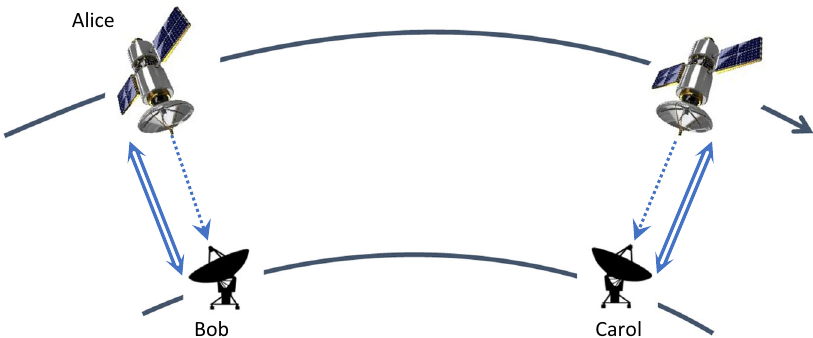
Fig. 1 Long-range quantum key exchange with satellite as trusted node. The dotted arrows represent quantum channels between the satellite (Alice) and each of the users (Bob and Carol). The white arrows represent classical public discussion channels, used to process the keys. By using both quantum channels and discussion channels, Bob and Carol can build a secret shared key. However, this secret key is also known to Alice, who therefore must be trusted by the